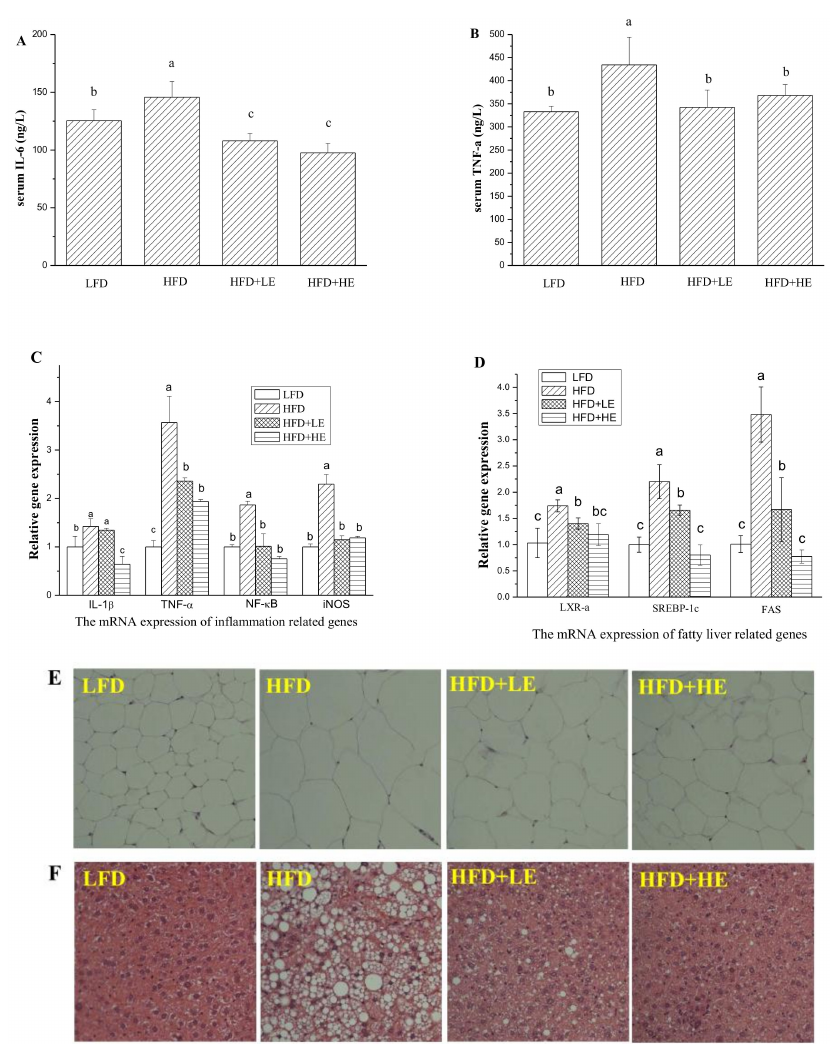
Figure 4. Effects of SCPE on the levels of serum IL-6 ( A ), TNF- α ( B ), inflammation-related genes in liver ( C ), fatty liver-related genes ( D ), and H&E staining of adipose ( E ) (200 × ) and liver tissue ( F ) (200 × magnification). Different lower-case letters correspond to significant differences at p <